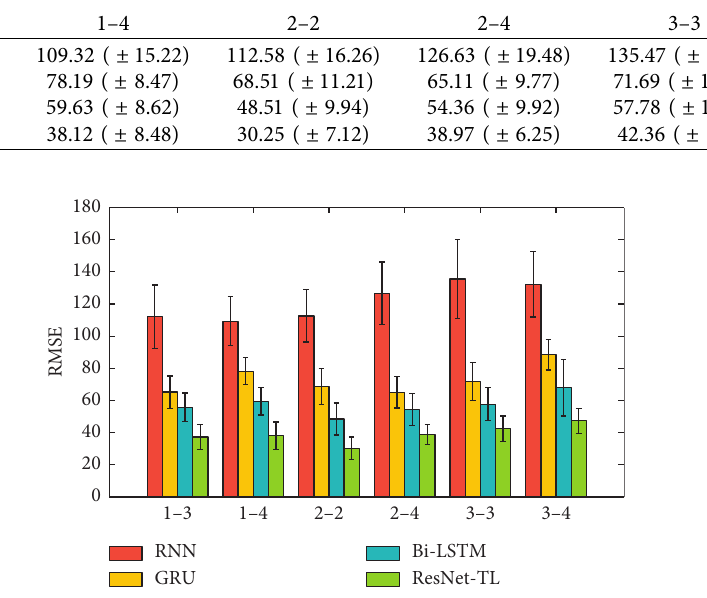
Figure 9: Confidence interval of RMSE for different methods.